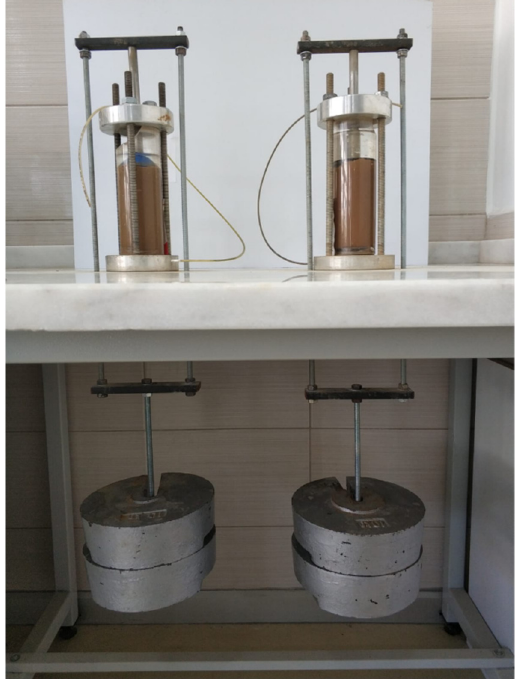
Figure 4. Preparation of reconstituted samples by consolidation from